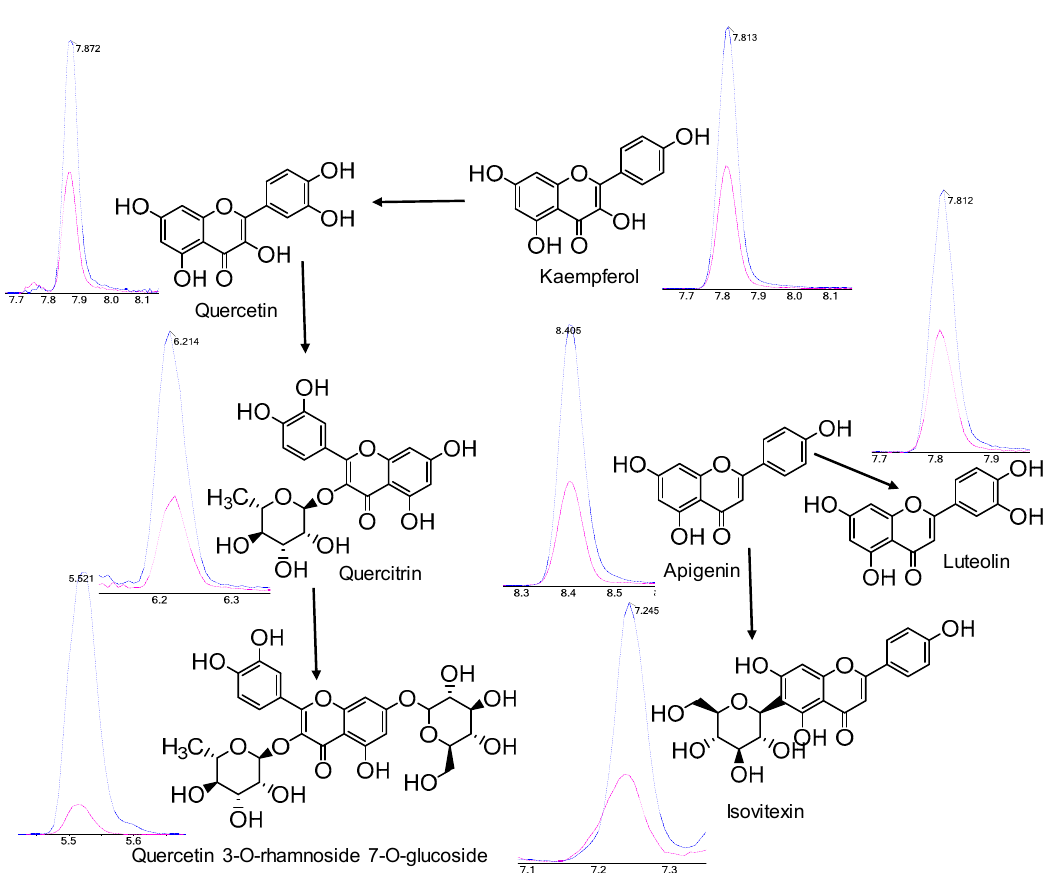
Figure 4. Pathway of flavone and flavonol biosynthesis adapted from the KEGG pathway. Blue line and red line indicate the extracted ion chromatograms for the individual flavonoids in T. ledebouri and T. chinensis , respectively. KEGG, Kyoto Encyclopedia of Genes and